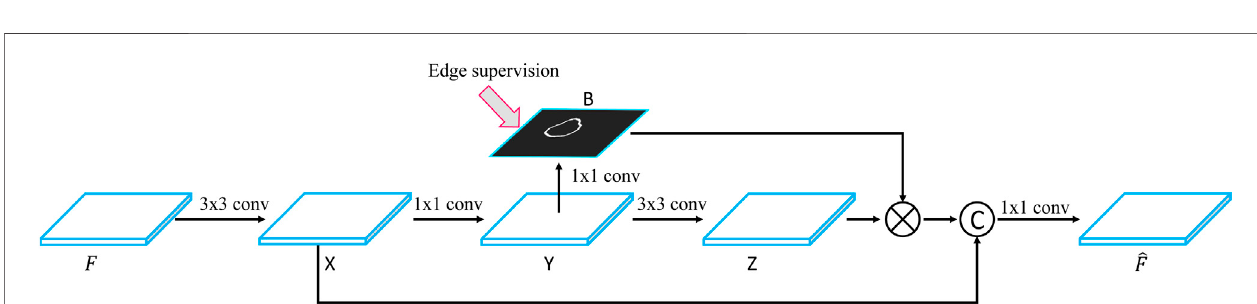
FIGURE 3 | Flowchart of the BGFE module. F and (cid:1) F are the feature map and the re fi ned feature map, respectively. Best viewed in color.